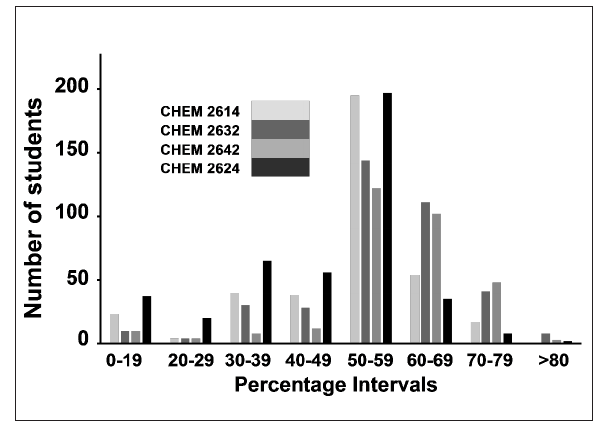
Number of first degrees conferred on students who started